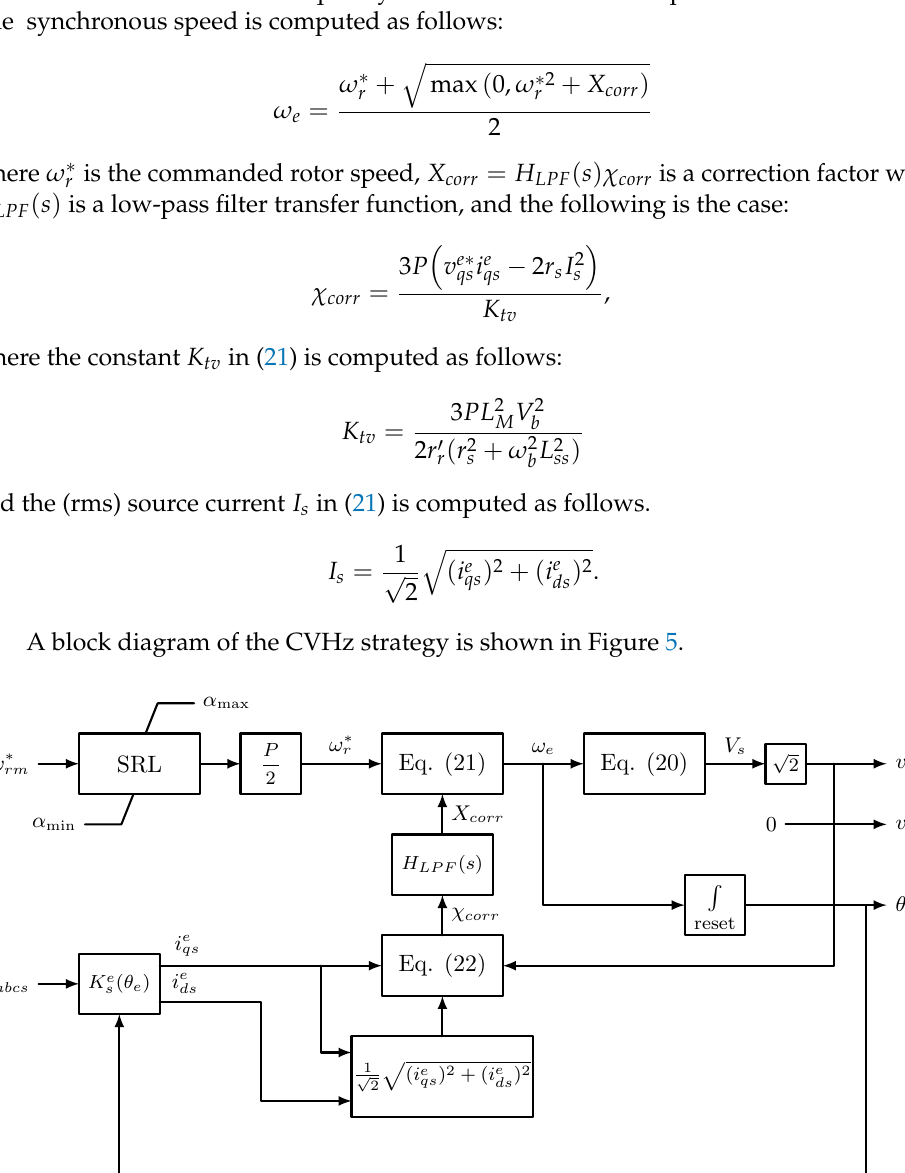
frequency, ω e , and voltage magnitude, V s . The slew rate limiter (SRL) limits the ramp